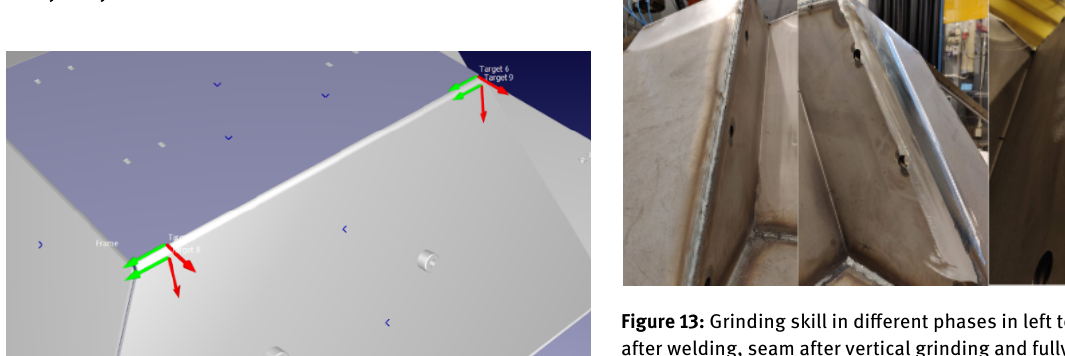
Figure 13: Grinding skill in different phases in left to right: seam after welding, seam after vertical grinding and fully grinded seam